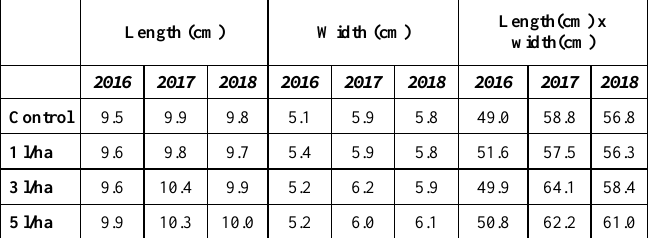
Table 6. Leaf size (Debrecen – Pallag, 2016-2018) Length (cm) Width (cm)